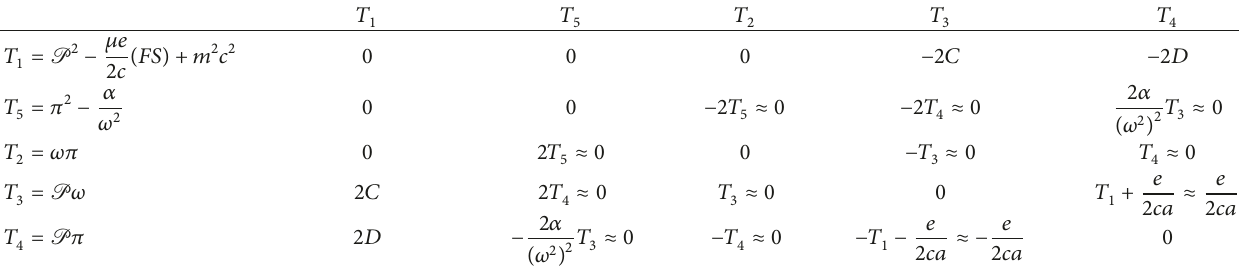
Table 1: Algebra of